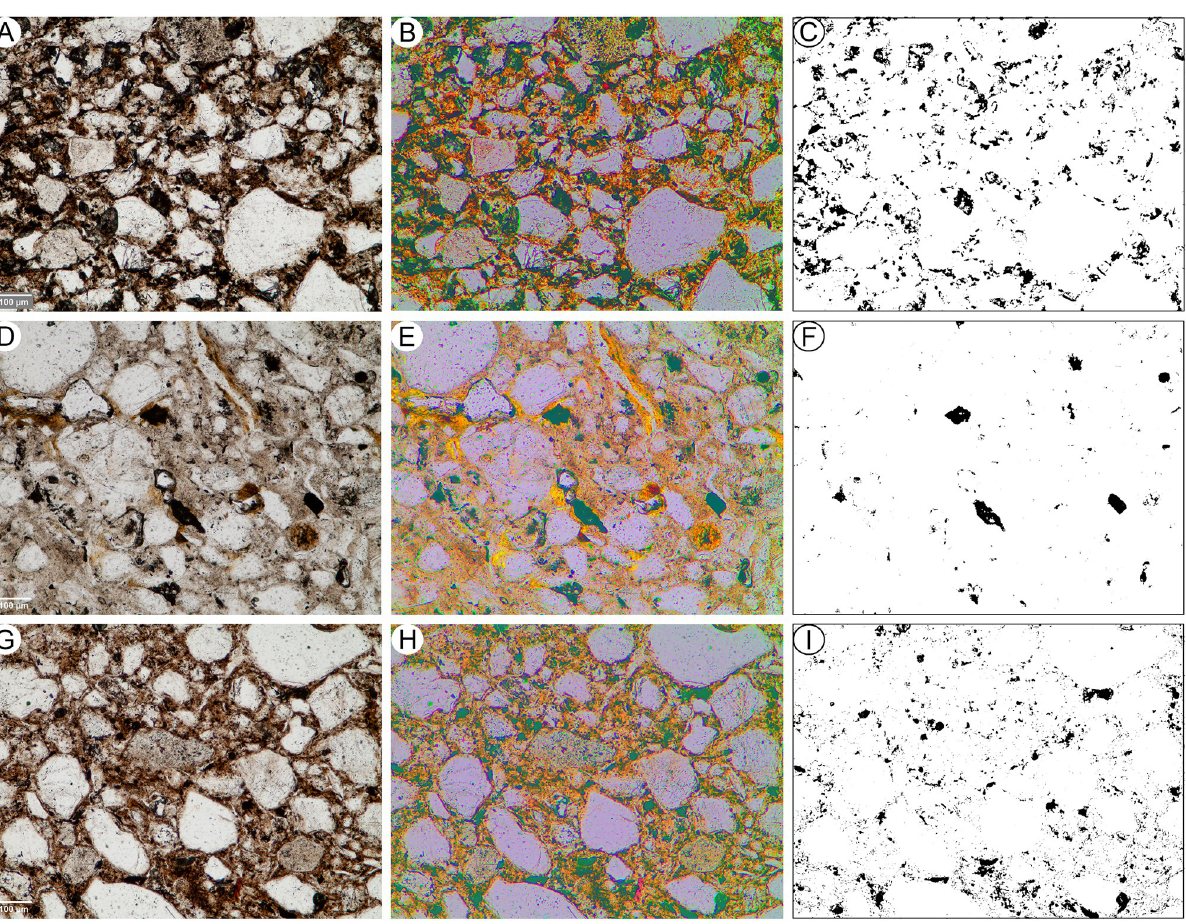
Fig 10. Micromorphology of the black clay banks. A-C: “black clay band” BCB1, (sample AMZ17/4/3-4-5), with dominant unsorted AOM aggregates and frequent Fe-oxide impregnations of the micromass. D-F: northern aspect of BCB1 (BCB1-N, sample AMZ17/2/3-4, upper part), with isolated large AOM aggregates and sparse punctuation and strong Fe-oxide impregnation of the micromass. G-I: clod of BCB1 in BHS (sample AMZ17/1/3-5, upper part), with frequent to dominant unsorted AOM aggregates.